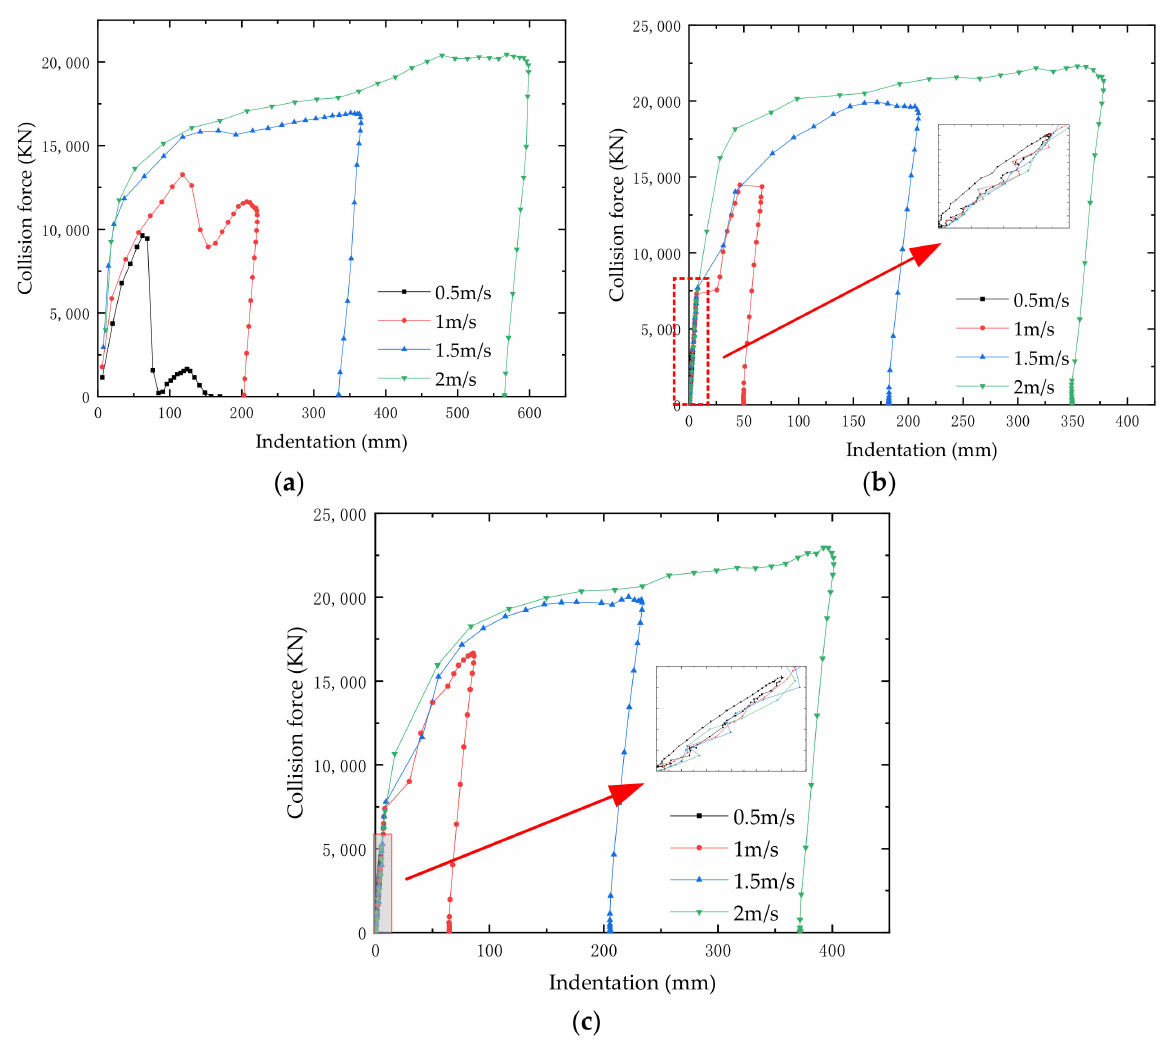
Figure 17. Collision force–indentation curves during collision. ( a ) unreinforced pipe; ( b ) hexagonal honeycomb reinforced pipe; and ( c ) arrow honeycomb reinforced